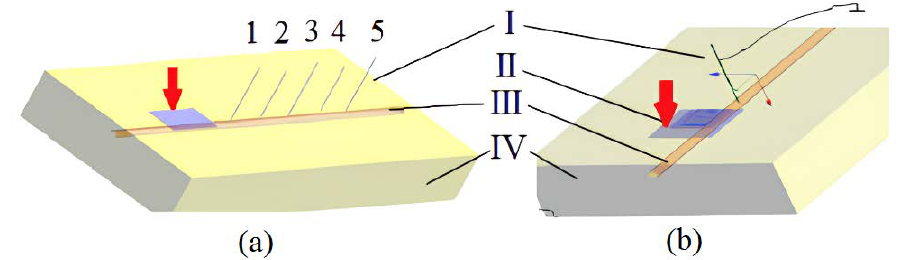
Figure 2. The location change ( a ) and size ( b ) of the electrode system (I—needle-electrode; II—the attached electrode; III—venous vessel; IV—soft tissue).